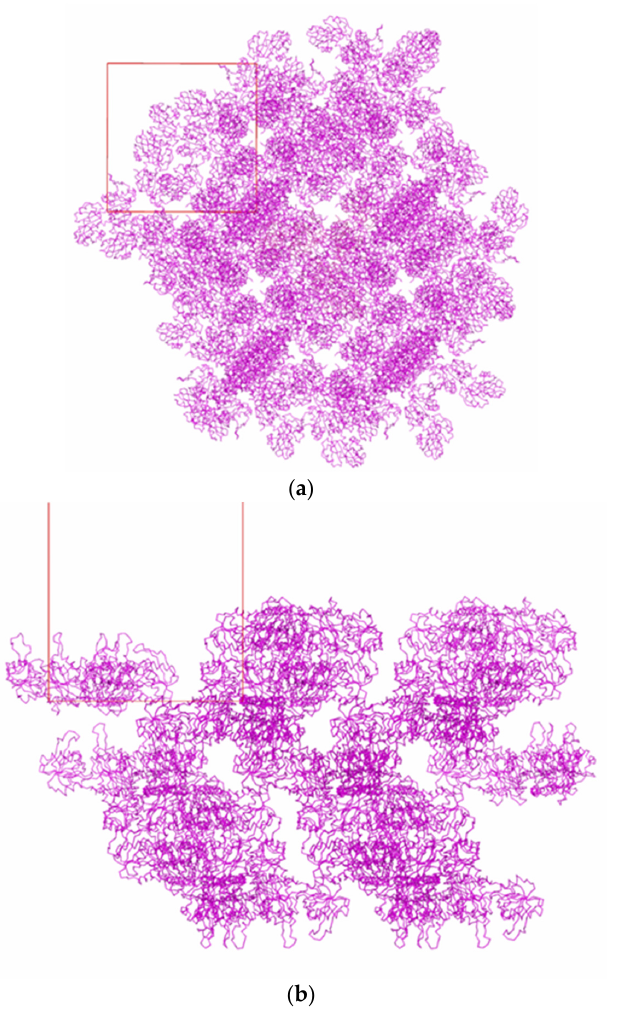
Figure 6. Packing of TthPRPPS2 molecules in the P4 1 2 1 2 crystal modification: view along the c axis ( a ); view in the direction perpendicular to the c axis ( b ).